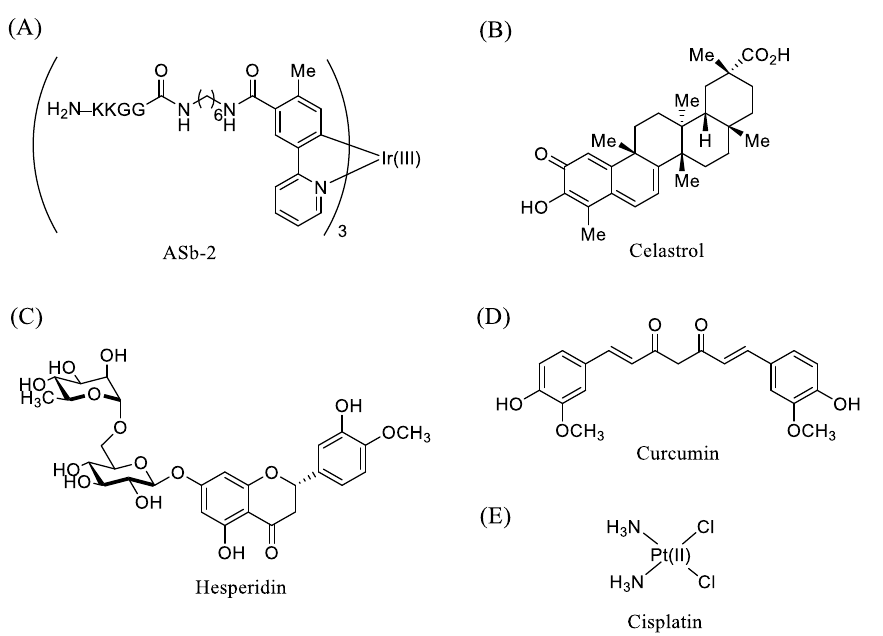
Figure 1. The structures of ( A ) ASb-2, ( B ) celastrol, ( C ) hesperidin, ( D ) curcumin, and ( E ) cisplatin.